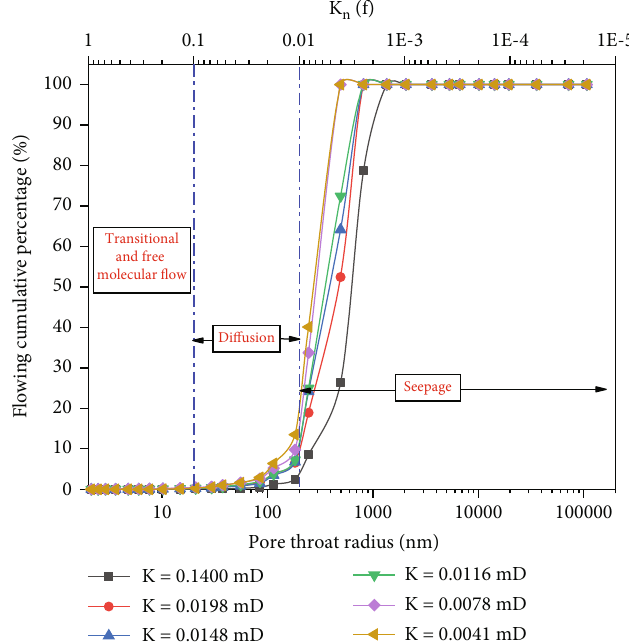
Figure 2: Cumulative contribution of pore throat fl